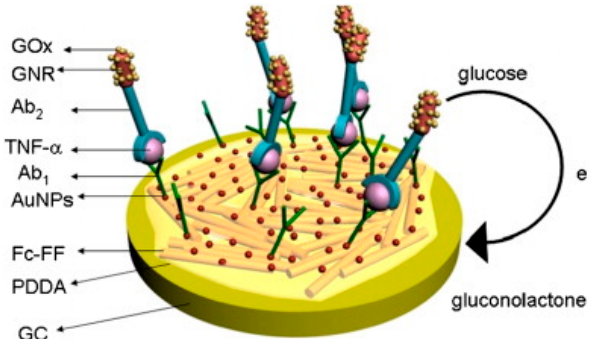
Figure 9. Schematic illustration of the GCE/Fc ‐ PNW/PDDA/AuNP/Ab 1 , GNR ‐ GOx ‐ Ab 2 im ‐ munosensor for TNF α detec Table 1. Ab 2 functionalized with gold nanorods (GNRs) and glucose oxidase (GOx) are brought close to the electrode upon sandwich immunoreaction. GOx converts glucose to gluconolactone. Reprinted from [124] with permission from Elsevier.